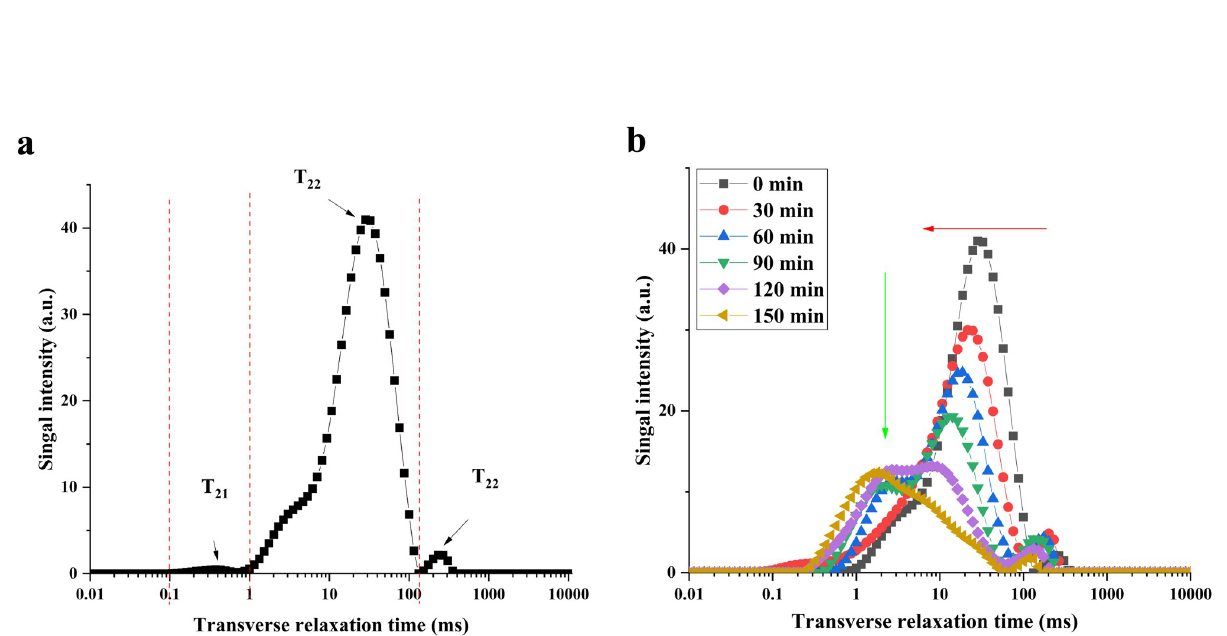
Fig 3. Transverse relaxation time (T 2 ) curves for AR pieces during drying. (a): Sample not dried. (b): Samples at different drying time.